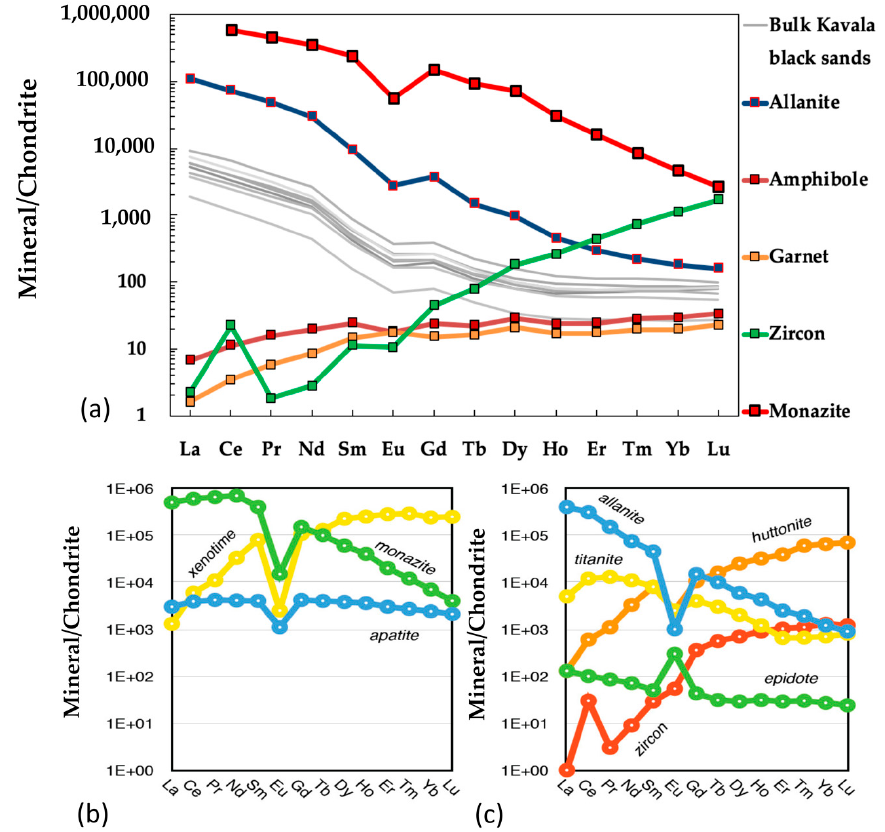
Figure 4. Chondrite-normalized REE patterns (upper) for the main U-, Th- and REE-bearing minerals ( a ) of coastal heavy minerals sands of Kavala region [33]. Chondrite-normalized REE patterns (lower) of accessory phosphates ( b ) and silicates ( c ) are from Bea [66]).